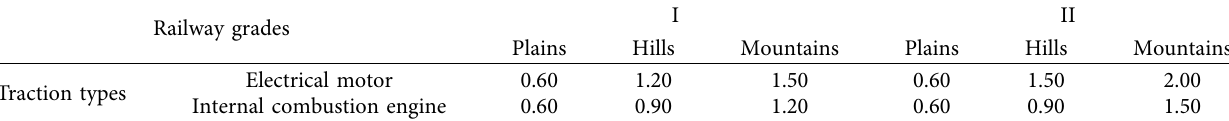
Table 5: Maximum slope of railways (unit: